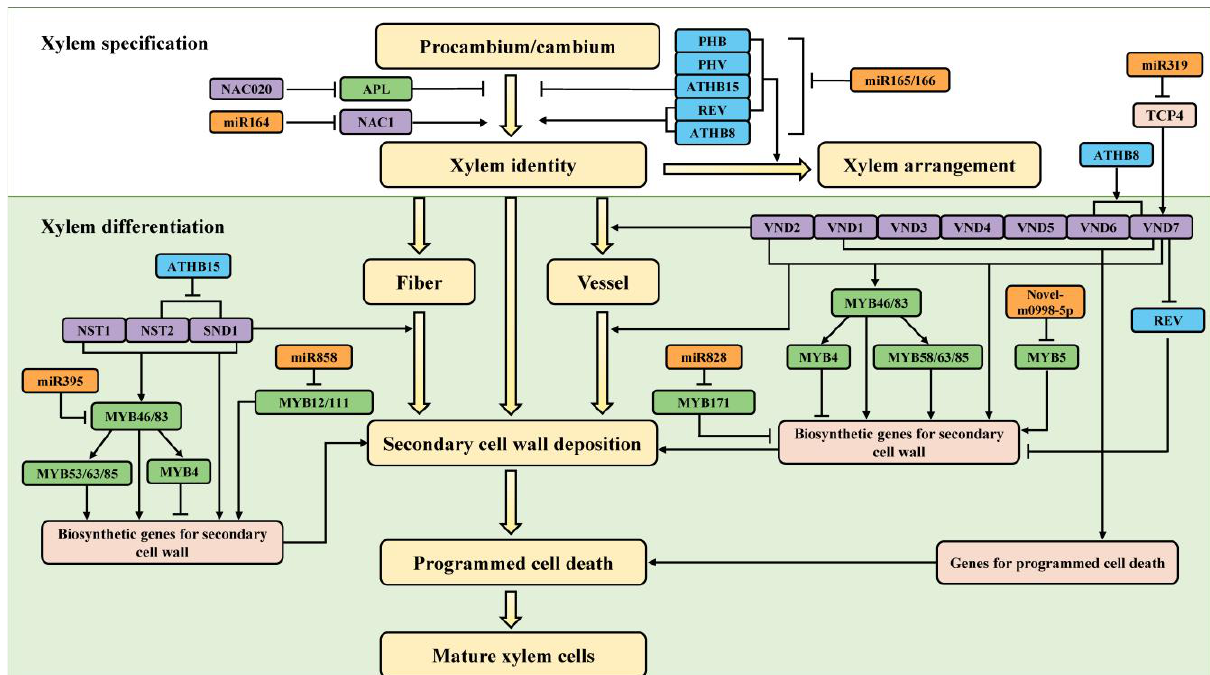
Figure 2. Genetic networks of xylem development regulated by HD - Zip III , MYB and NAC transcription factor genes and their upstream microRNAs. HD - Zip III , MYB and NAC genes are shown in blue, green and purple boxes, respectively. HD - Zip III genes are primarily involved in the differentiation of procambium or cambium into xylem and arrangement patterns of the xylem. MYB genes mainly regulate the development of xylem secondary cell walls. NAC genes chiefly participate in xylem vessel differentiation and secondary cell wall development. These three types of transcrip- tion factor genes are regulated by different upstream microRNAs. Black arrows represent activation, black lines with bars represent repression. The functions of most genes included in Figure 2 have been demonstrated in poplar.